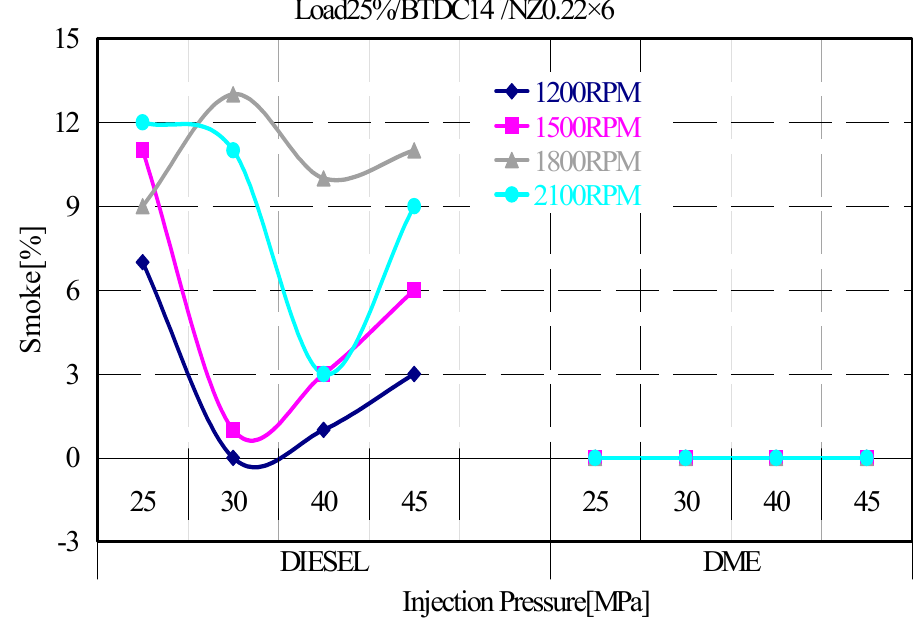
Figure 7. Smoke characteristics of diesel and DME engines without pilot injection as a function of injection pressure and engine speed.